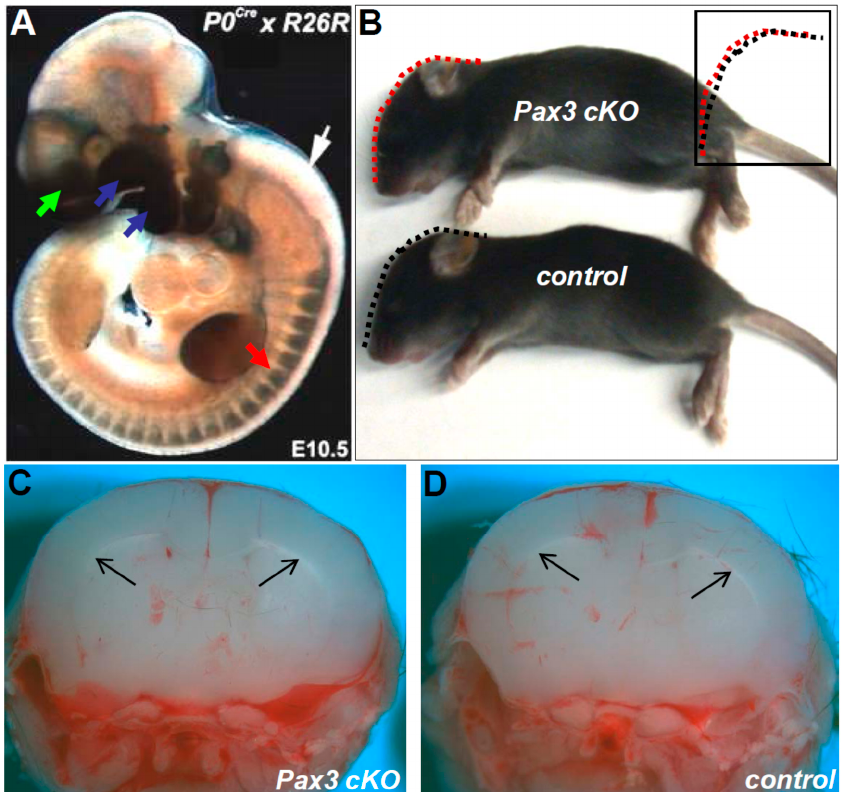
Figure 5. Pax3 flox { flox /P0-Cre conditional knockout mice do not exhibit congenital hydrocephalus, indicating that restricted loss of Pax3 within the migratory neural crest is insufficient to cause